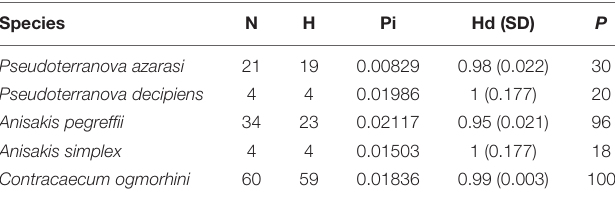
TABLE 1 | Genetic statistics based on cox2 for populations of the Anisakidae nematodes with more than three sequences (sequences from the previous studies were